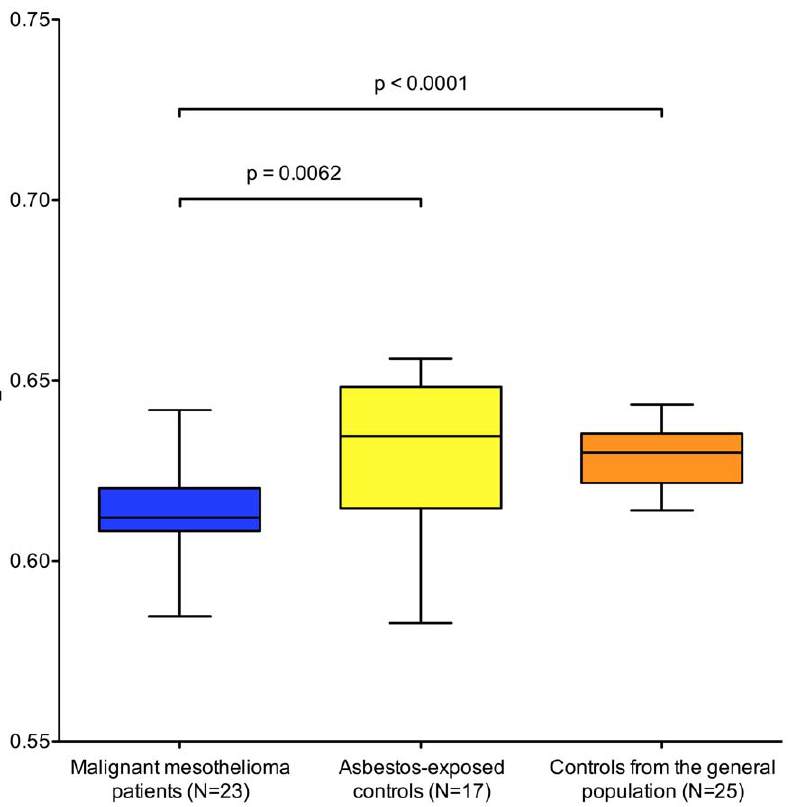
Figure 3. Box plots of relative expression of miR-103. Relative expression of miR-103 in the cellular fraction of human peripheral blood of malignant mesothelioma patients (blue), asbestos-exposed controls (yellow), and controls from the general population (orange). Expression values were normalized to miR-125a and expressed as 2 2 Ratio . Mann-Whitney test was performed to examine group differences.